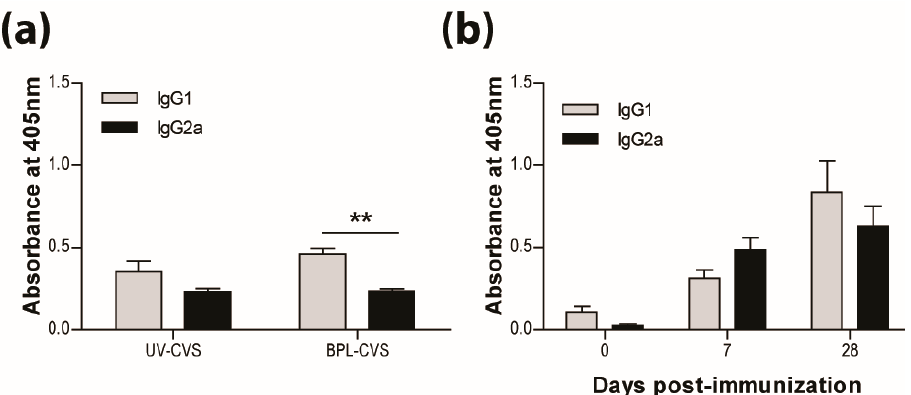
Figure 2. IMOVAX ® is protective through the induction of a mixed Th1/Th2 immune response. Virus-specific Ab isotype was determined by ELISA 10 days following immunization with either 1 × 10 5 f.f.u. of UV- or BPL-inactivated CVS-F3 RABV ( a ) or 0.25 IU of IMOVAX ® ( b ). Results are expressed as mean absorbance ±SEM in OD (dilution 1:20). Statistically significant differences between groups ( n = 5–10 per group) are denoted as follows: ** p ≤ 0.005.